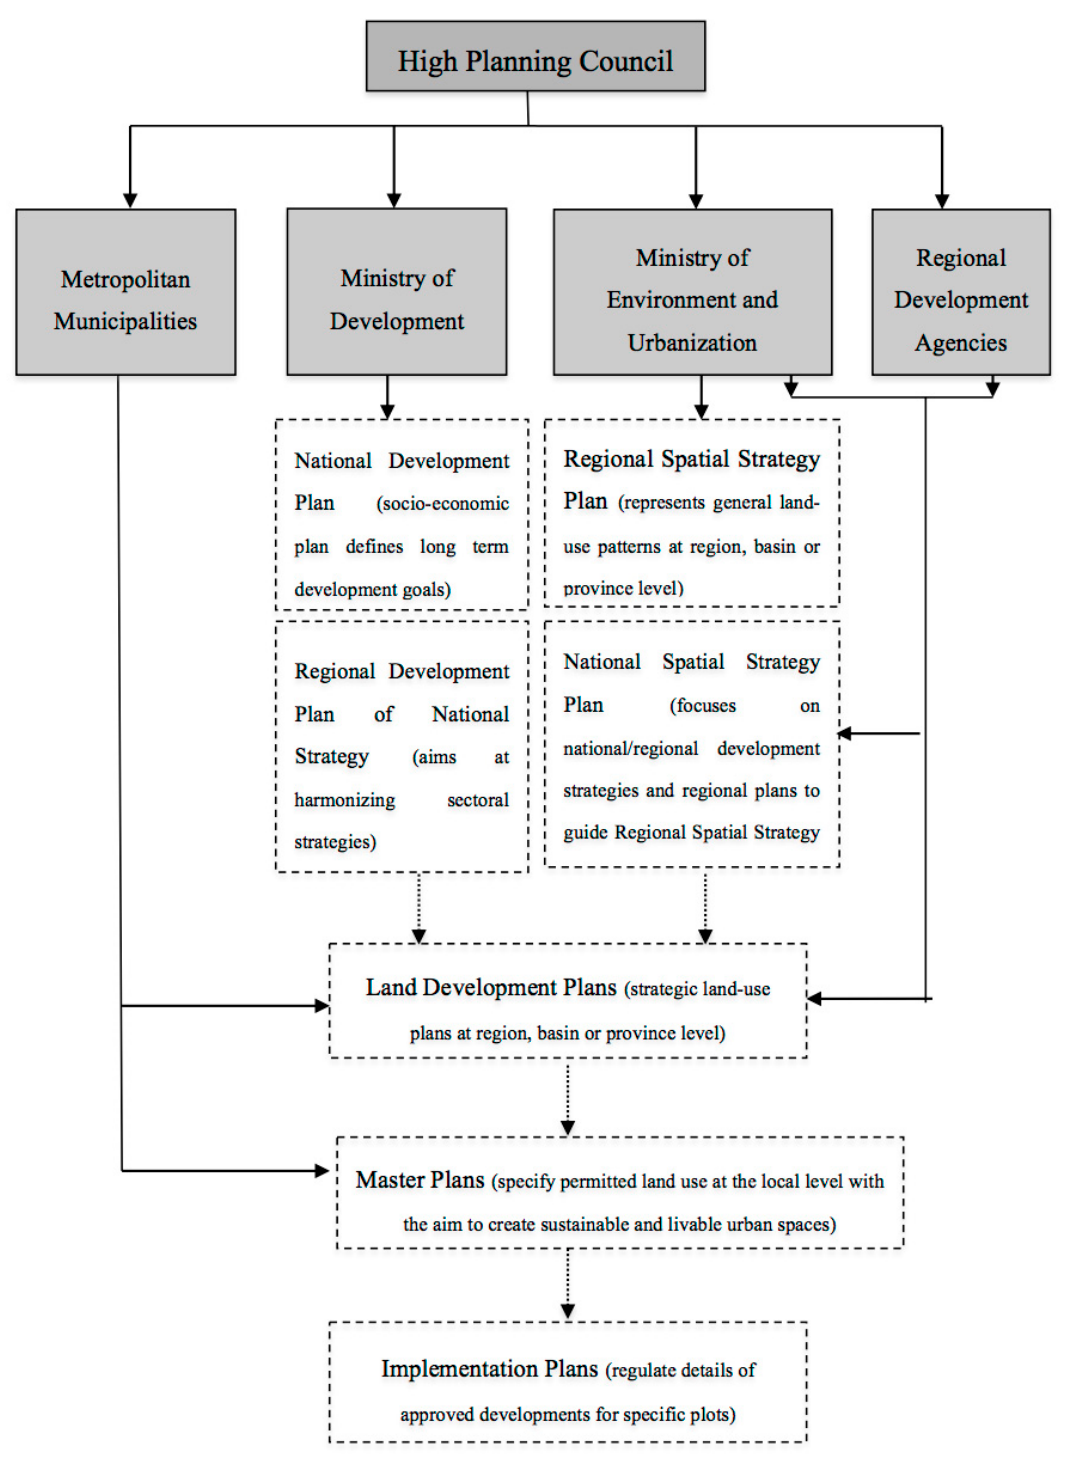
Figure 3. The planning and institutional system of Turkey. Source: Adopted from OECD 51 .